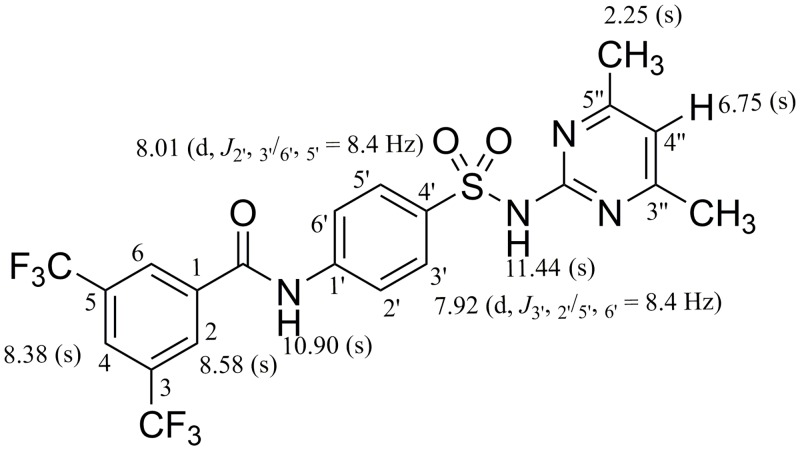
1H-NMR chemical shifts of compound 6.